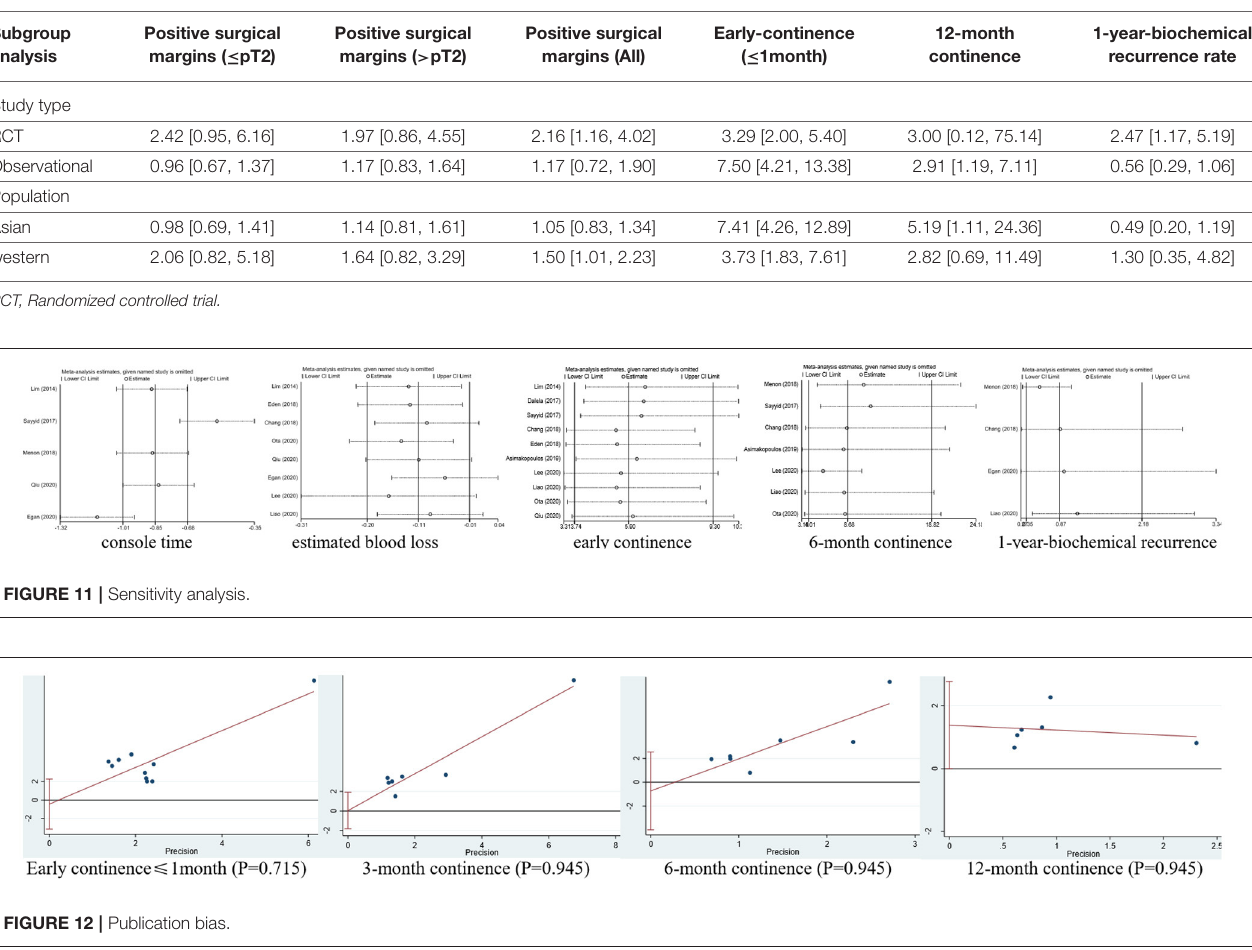
TABLE 2 | Subgroup analysis.